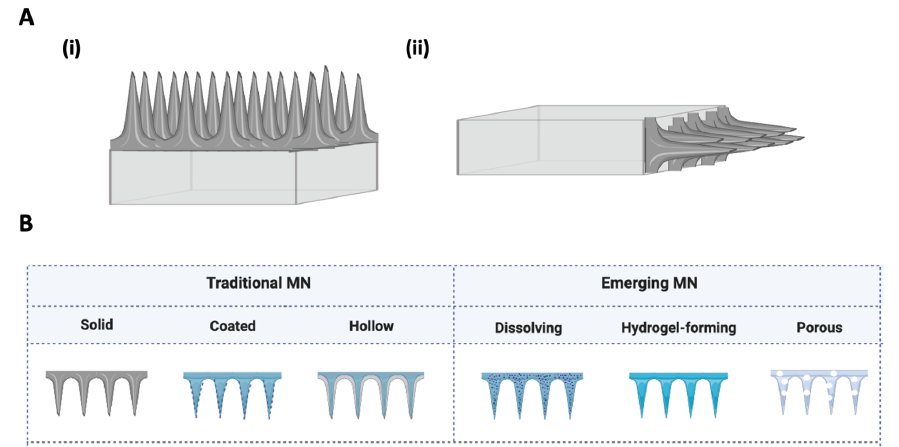
Figure 1. Schematic representation of MNs. ( A ) ( i ) out-of-plane and ( ii ) in-plane construction. ( B ) Traditional and emerging MNs structuring approaches according to drug delivery application.